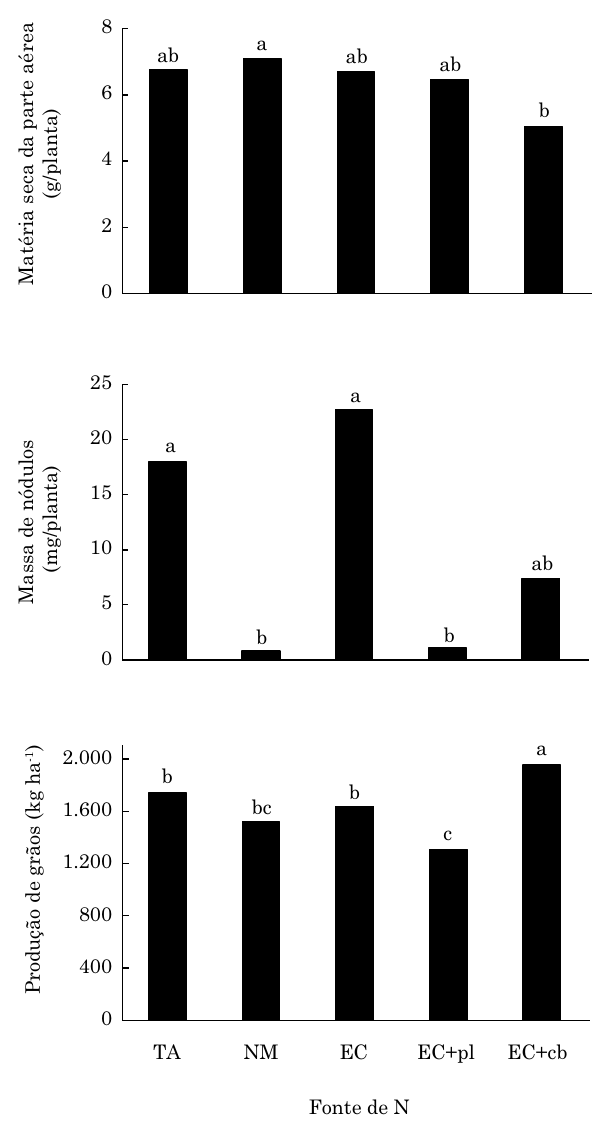
Figura 4. Produção de matéria seca da parte aérea e matéria seca de nódulos quando da formação de vagens e produção de grãos, da cultivar de feijoeiro comum Ouro Negro, no experimento em Macaé, RJ, sem adubação nitrogenada (ta - testemunha absoluta)